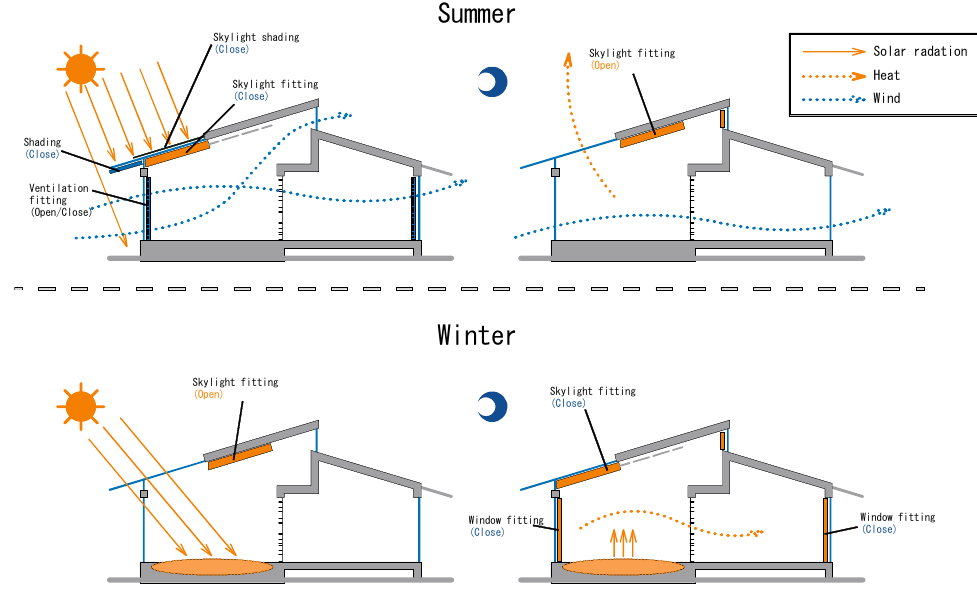
Figure 4. Operation of the fitting adjustments depending on season and time.